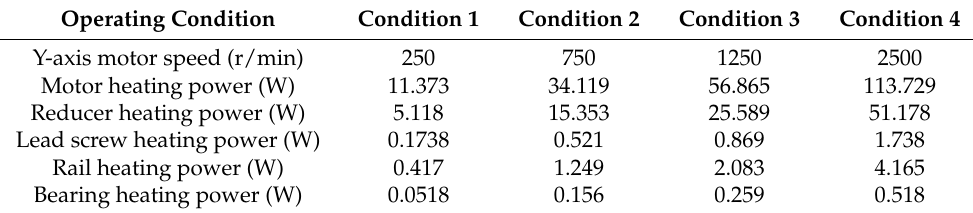
Table 2. The heating power of each component of the Y-axis motor at different